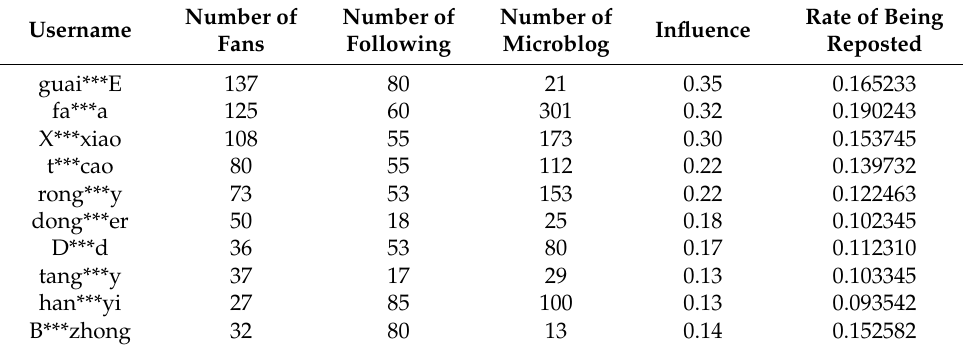
Table 5. Some data of microblog influence.